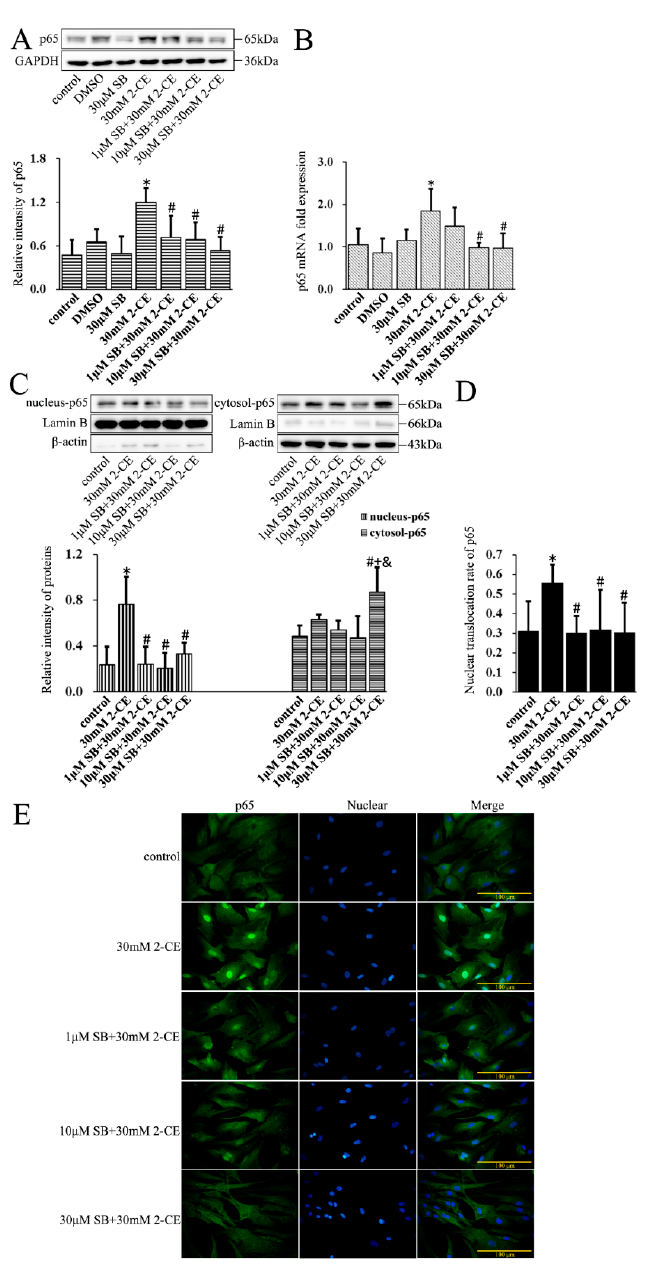
Figure 6. Role of p38 mitogen-activated protein kinase (p38 MAPK) signaling pathway in 2-CE induced nuclear translocation of p65 in astrocytes. Astrocytes were pre-treated with 1, 10, and 30 µM SB for 1 h and then treated with 30 mM of 2-CE for 12 h. ( A ) The levels of p65 in astrocytes measured by Western blotting; ( B ) The p65 mRNA levels analyzed by RT-PCR; ( C ) The cytosolic and nuclear fraction of p65 measured by Western blotting; ( D ) The nuclear translocation rate of p65; ( E ) Immunofluorescence staining for p65 (400 × ). ( n = 4; mean ± SD; * p < 0.05 vs. control group, # p < 0.05 vs. 30 mM of 2-CE, + p < 0.05 vs. 1 µ M of SB, & p < 0.05 vs. 10 µ M of SB; one-way ANOVA followed by SNK